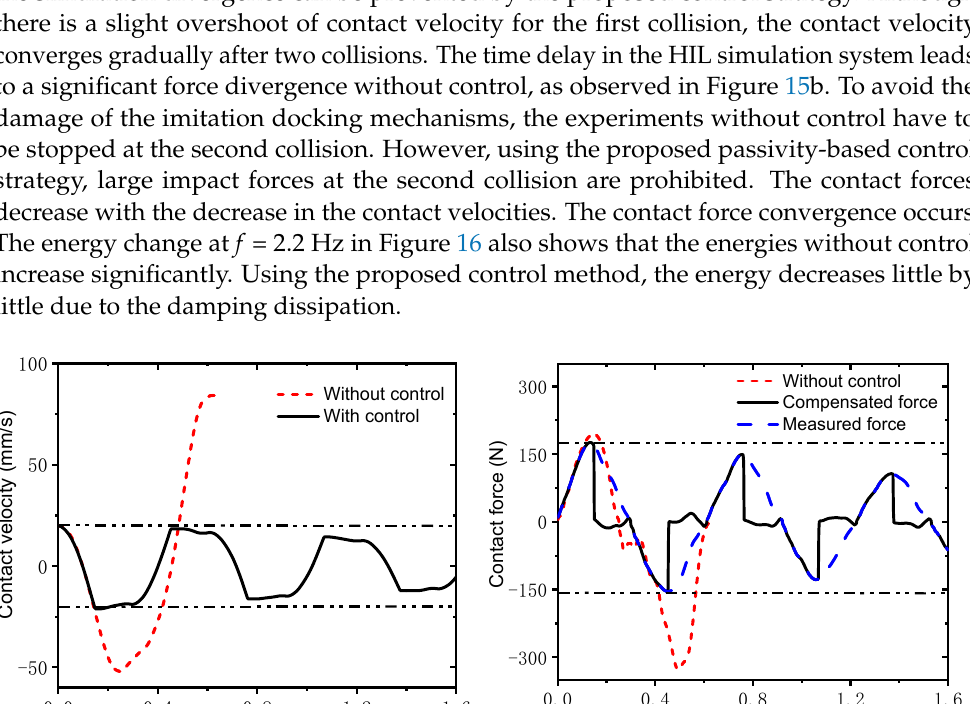
Figure 14. Estimates of damping in real collisions ( f = 2.2 Hz). ( a ) Identified results. ( b ) Standard deviation.